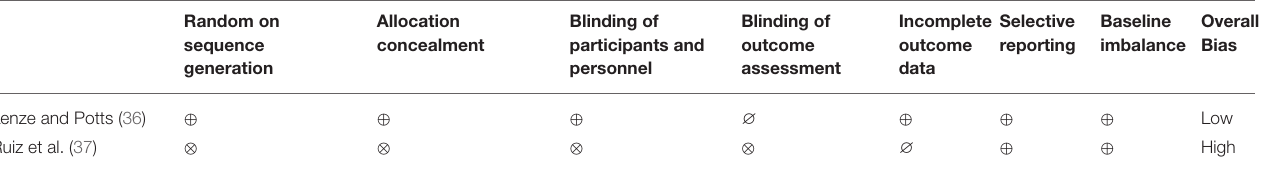
TABLE A1 | Assessment of study